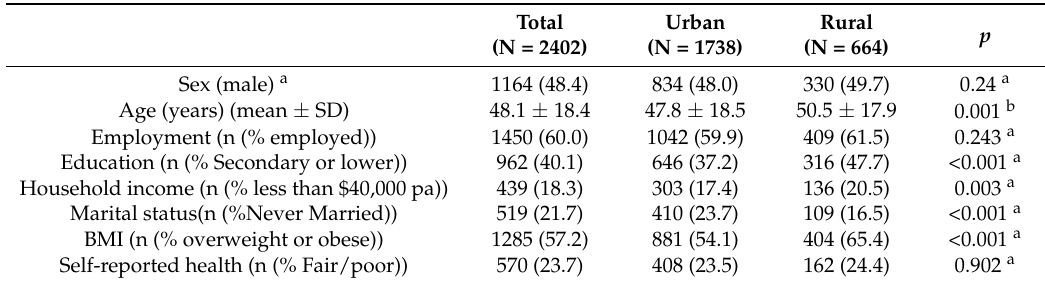
Table 1. Demographic profile of